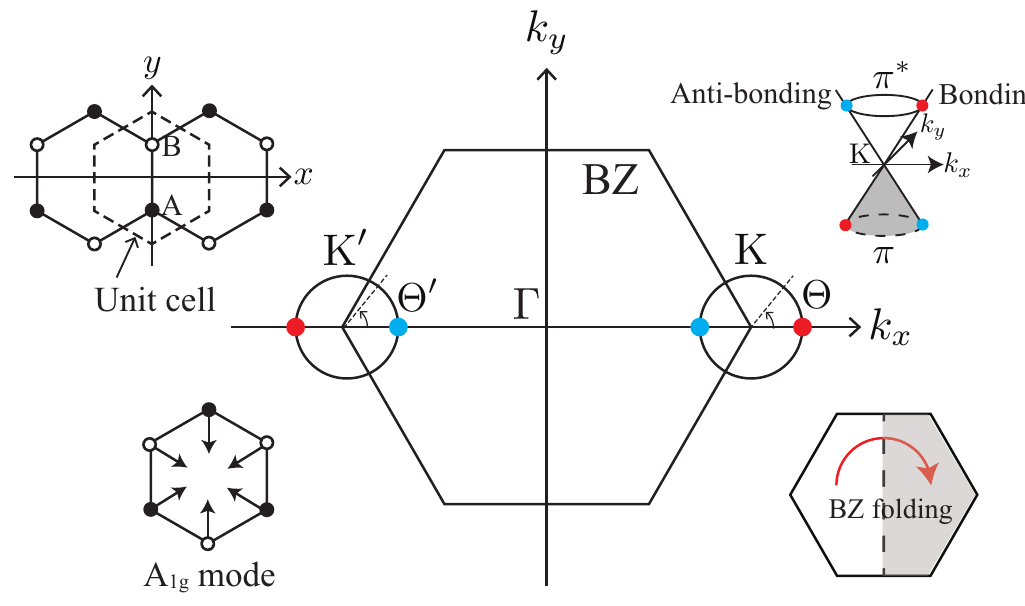
Figure 1. Graphene unit cell and BZ. The K (K ′ ) point is located at k where a is the lattice constant. The positions of the bonding and antibonding orbitals are marked by red and blue points on the iso-energy sections of the Dirac cones (circles). The Raman D band is composed of zone-boundary A stretching motions. The armchair edge identifies a state at ( k and causes the BZ